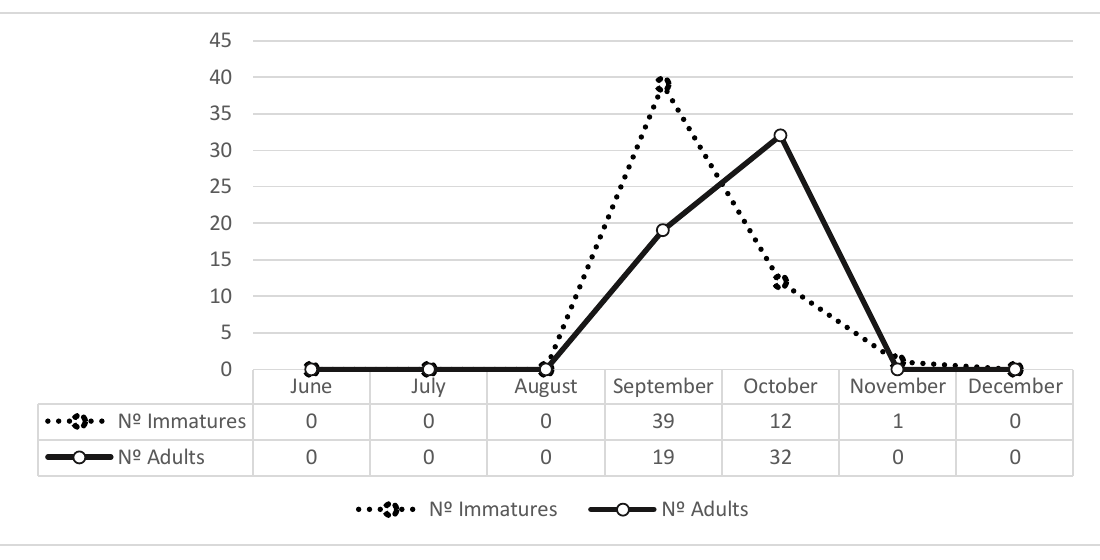
Figure 3. Number of Ae. albopictus specimens identified during REVIVE activities at Urr ô site from June to 20 December 2017. 12 June to 20 December